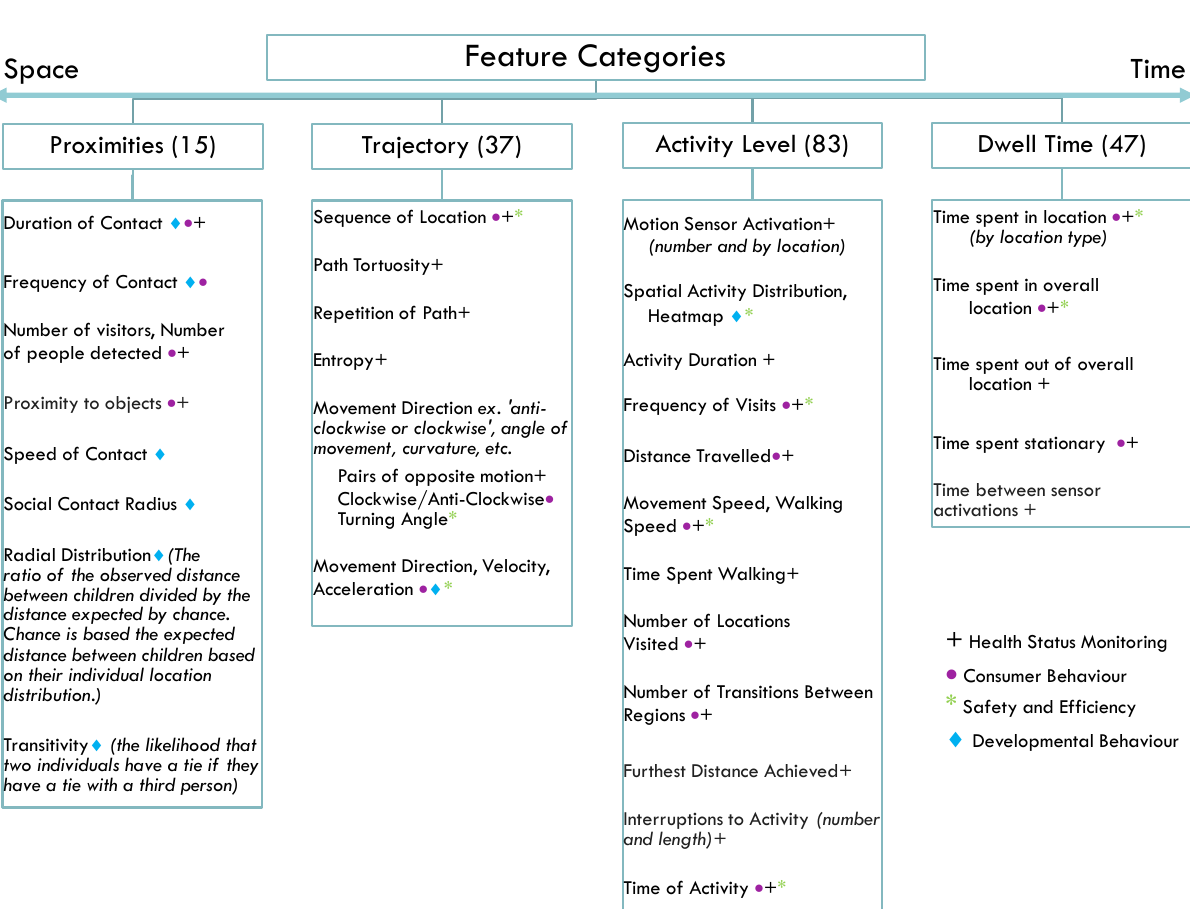
Figure 3. Breakdown of the feature categories and a list of the features observed within each category. The symbols described in the legend represent a binary indicator of whether one or more papers from the application sector denoted used the listed feature. Detailed results for each feature category with study references can be found in supplementary